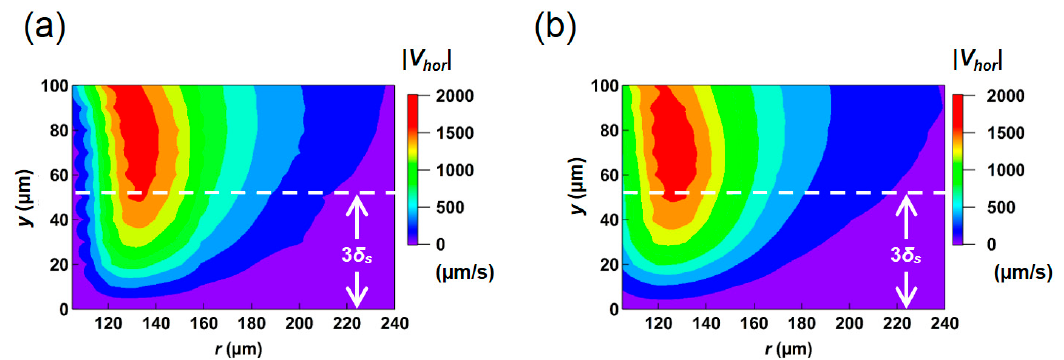
Figure 10. Contour plots of mean horizontal velocity magnitude | V hor | in r - y plane of ( a ) numerical result (Lagrangian averaging) and ( b ) PIV measurement. The dashed line indicates the Stokes layer thickness calculated based on the present experimental condition.